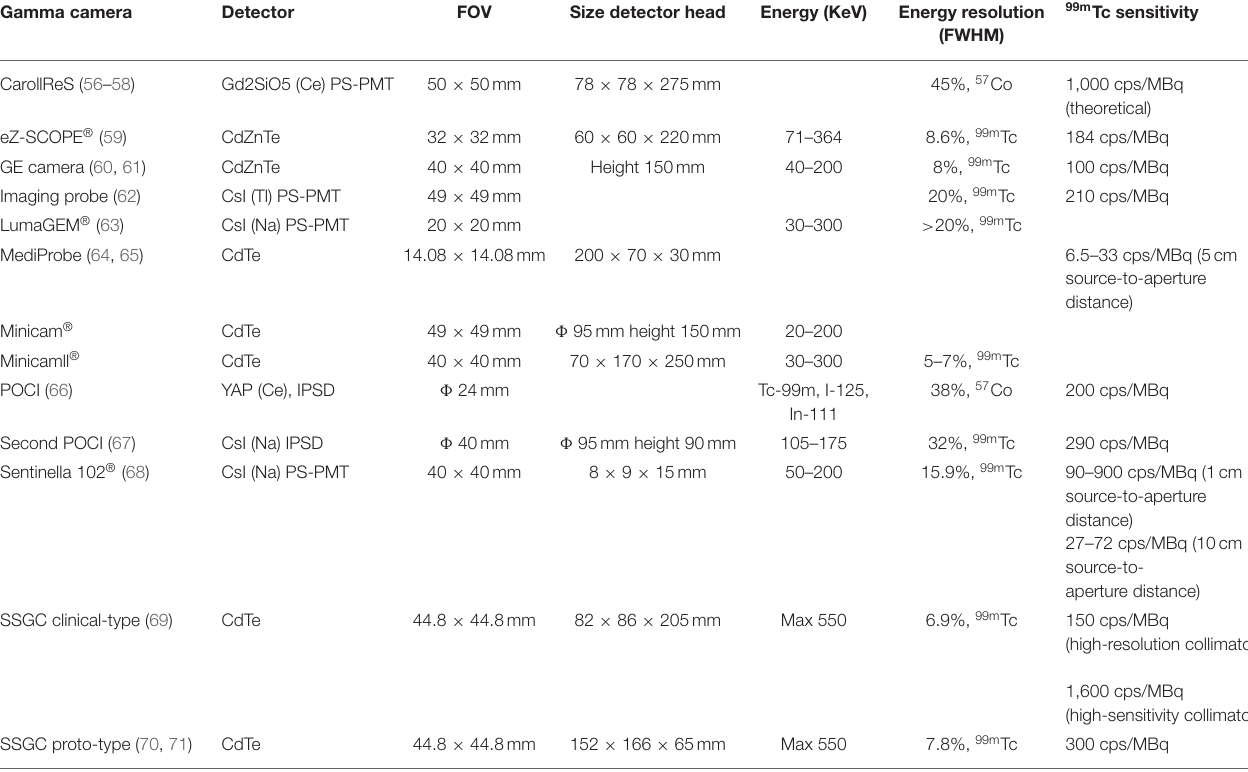
TABLE 2 | Summary of characteristics and performances of small gamma